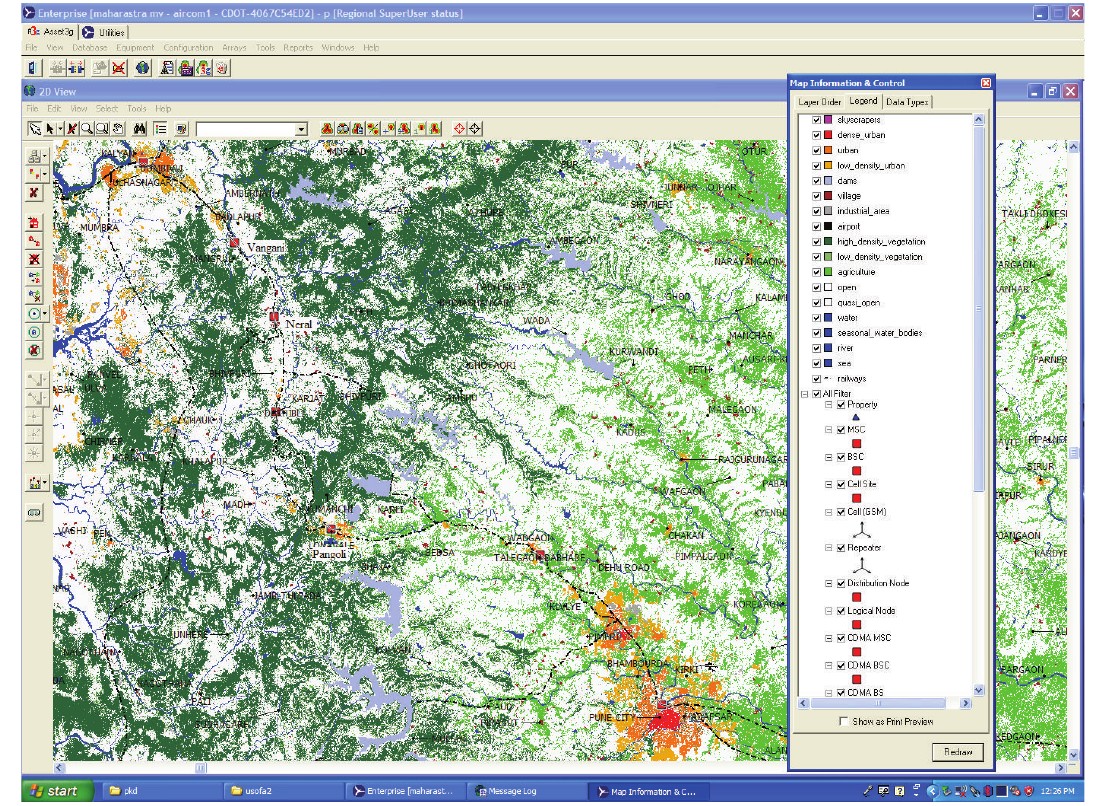
Figure 3: Clutter map of west Indian base